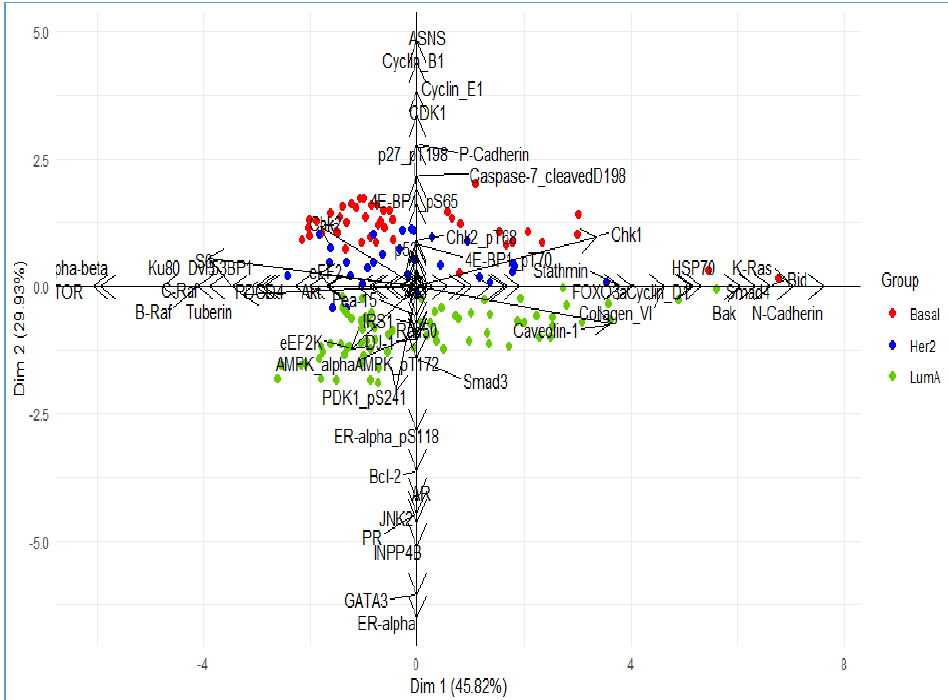
Figure 5. Elastic net HJ biplot representations.